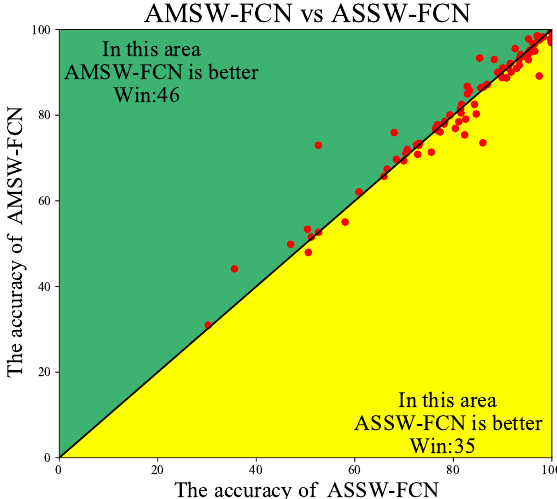
Figure 8. The pairwise comparison between AMSW-FCN and ASSW-FCN. The loss function for training the AMSW-NN contains the detail loss and mean loss as presented in Equation (8). In Section 4.1, λ 2 is set to 0 which means the high frequency is not suppressed. In this section, λ 2 is set to 0.01 as [16] to suppress the detailed coefficients. AMSW-FCN with this loss function called AMSW-FCN(L) is trained on the UCR archive again. The pairwise comparison between AMSW-FCN and AMSW-FCN(L) is shown in Figure 9.